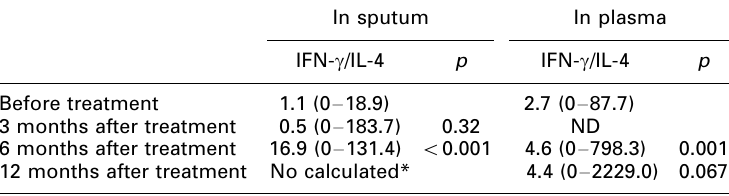
Table 4. Changes of IFN- g /IL-4 ratios during clarithromycin